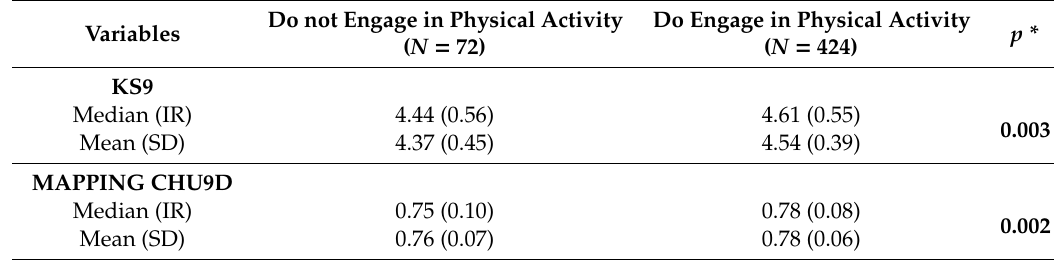
Table 4. Comparison of HRQoL values between children and adolescents with attention deficit hyperactivity disorder who do not engage in physical activity and those who do using the KS9 and MAPPING CHU9D